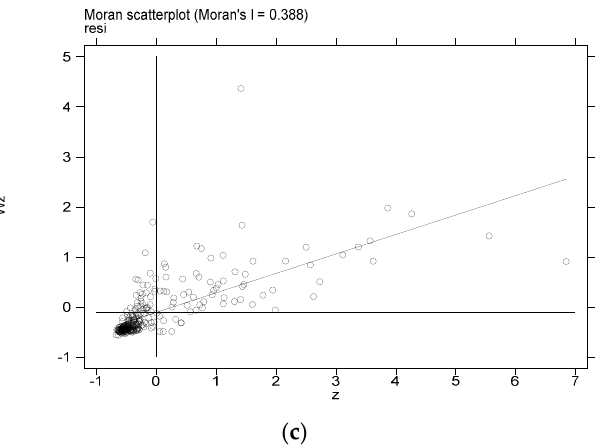
Figure 3. Urban economic resilience of Moran’s I scatterplot. ( a ) W1, ( b ) W2, ( c ) W3.